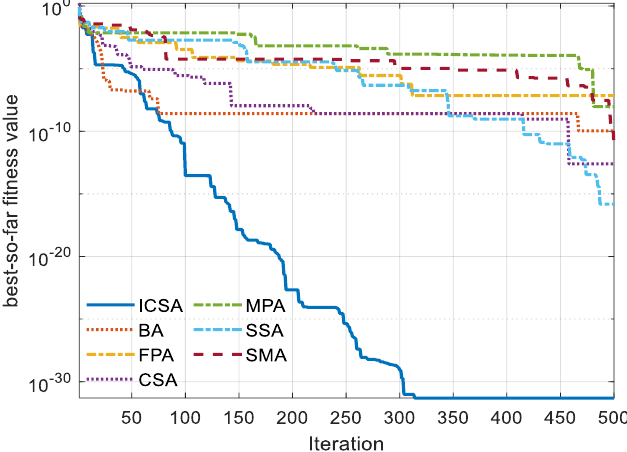
Figure 18. Convergence curve for F18.